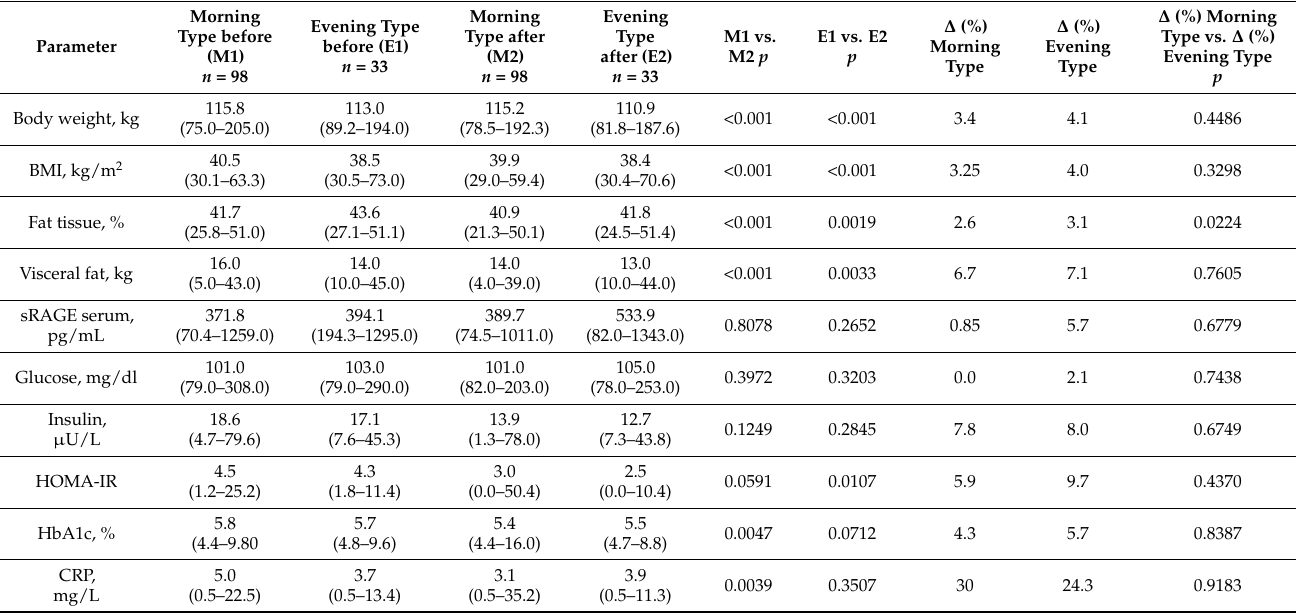
Table 2. Anthropometric and metabolic characteristics of the study group ( n = 131), taking into account measurement changes before and after caloric restriction, by chronotype; Wilcoxon signed-rank test. The values of the results in the study are given as a median (minimum–maximum). BMI (Body Mass Index), HOMA-IR (Homeostasis Model Assessment of